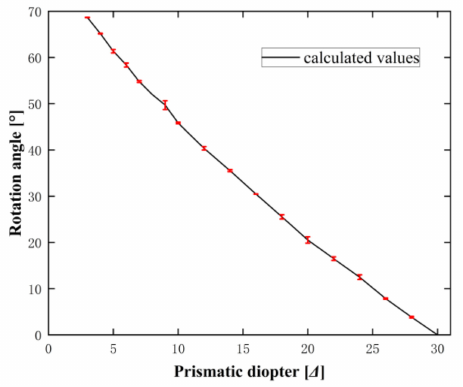
Figure 11. Dependence of rotation angle on the prismatic diopter of a